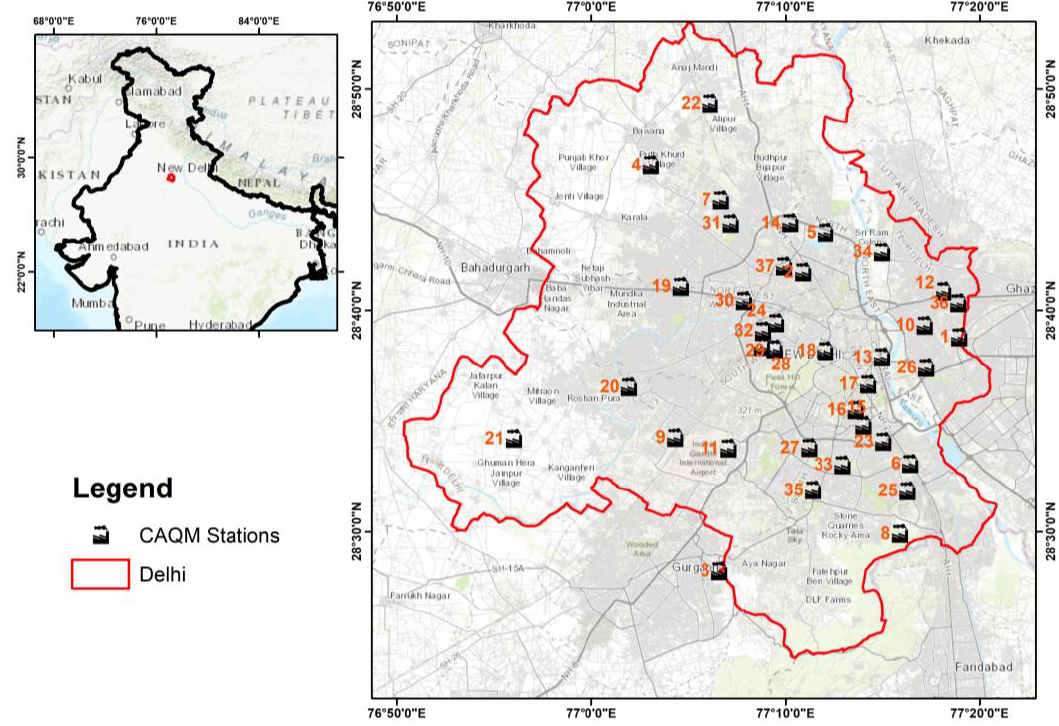
Figure 1. The study area map depicting the CAQM stations. The distribution of the 37 CAQM stations is shown on the map.